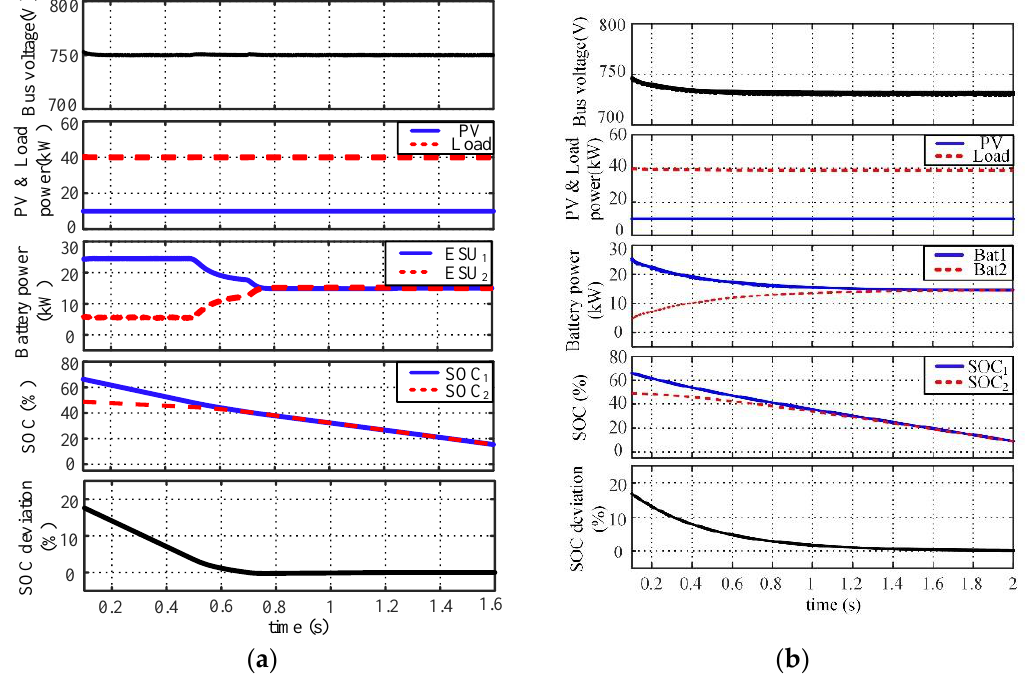
Figure 5. Waveforms of P dmax ≤ P < 2 P dmax in discharging. ( a ) Waveforms of the proposed method; ( b ) Waveforms of the method in [32].